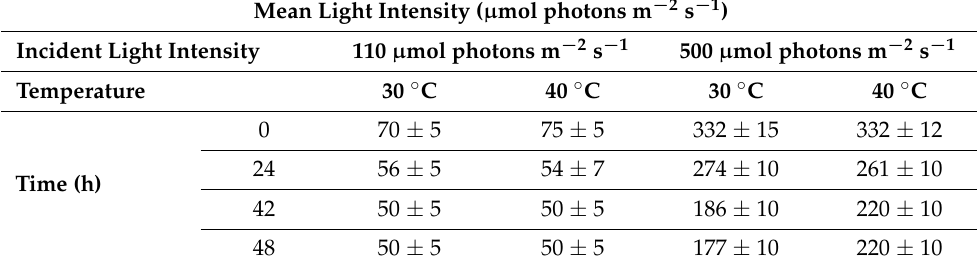
Table 1. Changes in mean light intensities experienced by the cultures during the experiment at different incident light intensities and